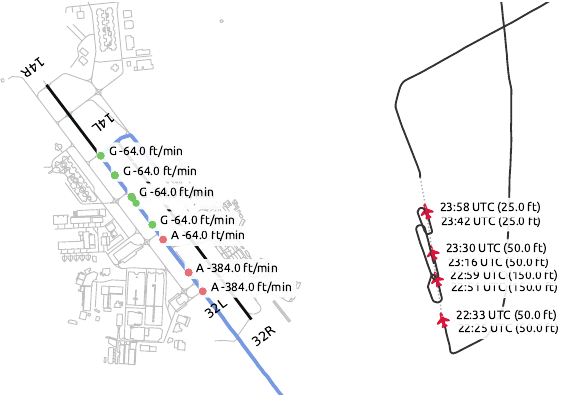
Figure 2. (Left) Flight DLH83K on 25 February 2017: it is very difficult to determine the exact landing point: the onground flag was activated after the vertical rate came close to zero. A long landing in this situation is not unreasonable, but these data cannot reasonably support this hypothesis. (Right) No onground flag is activated, but the trajectory of aircraft identifier ae0455 on 14 September 2020 suggests landing practice activity on an aircraft carrier off